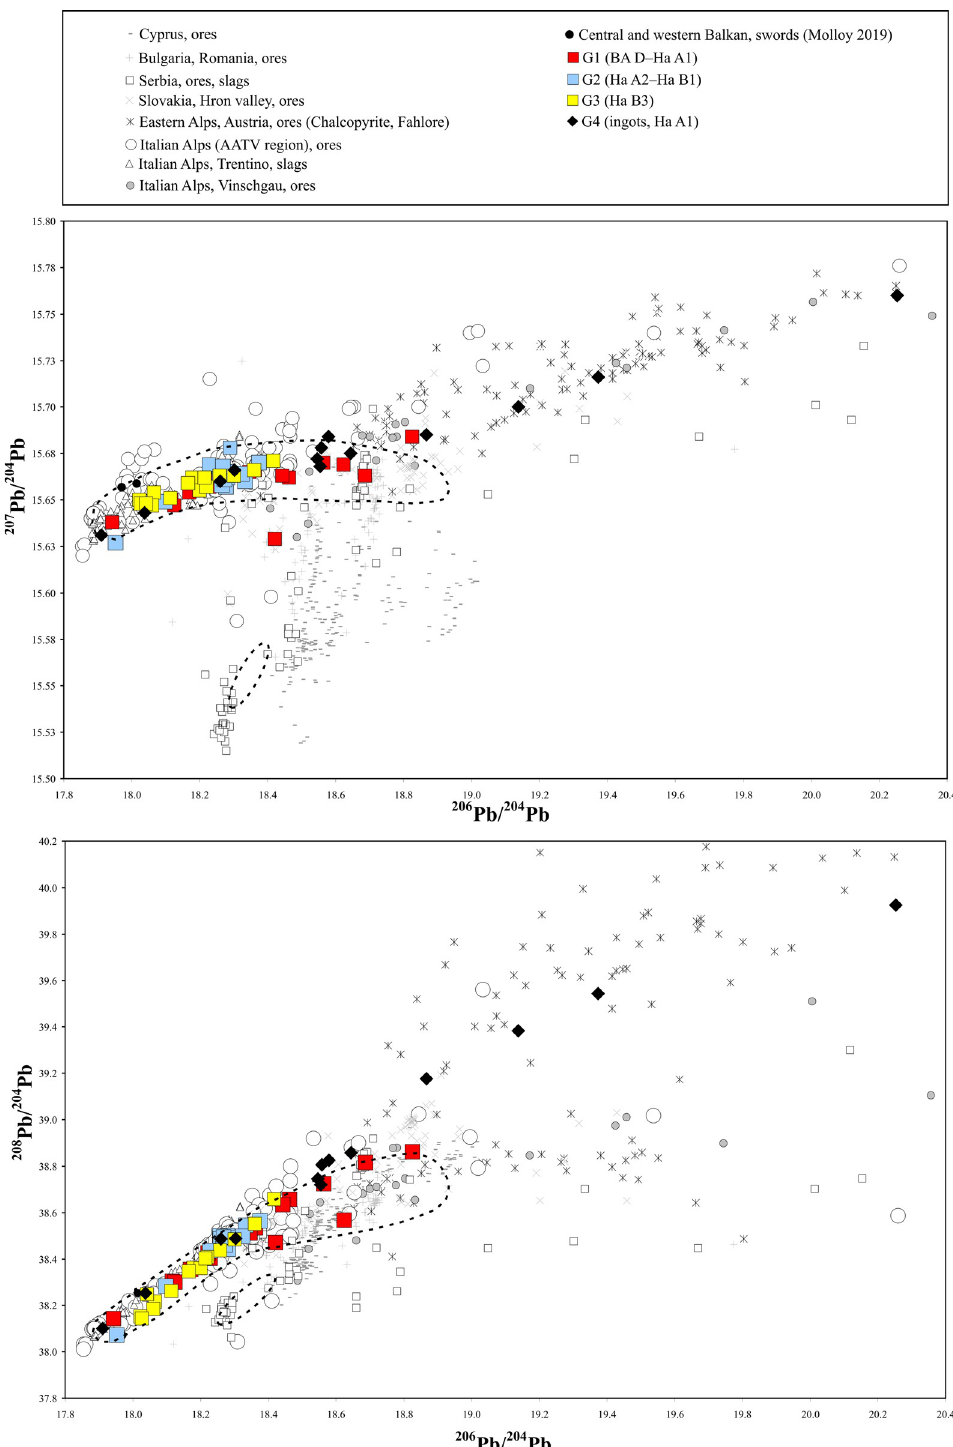
Fig 5. LI diagrams comparing LI signatures of the central and western Balkan objects under study with other major European, Balkan and Mediterranean ore fields. In the lead isotope diagrams, the artefact data from Groups 1–4 (58 squares and diamonds) is compared with those of ores and slags found in the Alpine region as well as in the Balkan area. The dotted ellipse circumscribe the lead isotope ratios of 134 additional LBA objects within the dataset. The three above mentioned objects that point to the copper ores from Cyprus are excluded from ellipse [89, 90] It becomes obvious that